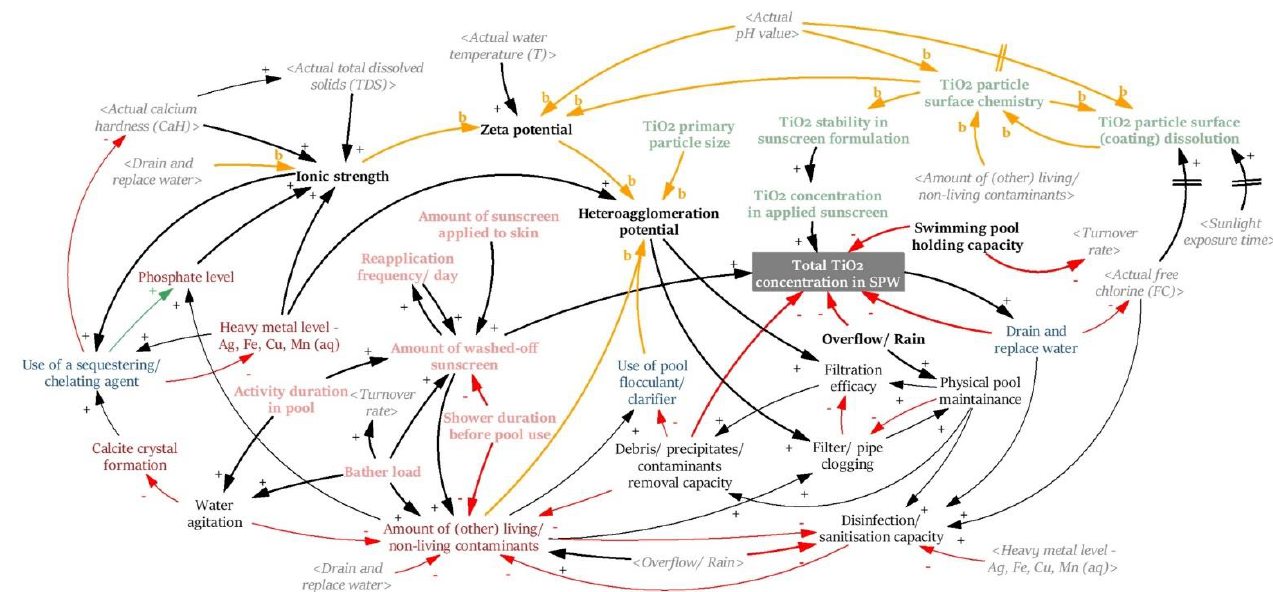
Figure 6. CLD 3: TiO 2 concentration in SPW. Colour code is the same as in the previous two figures. Additionally: pink variables represent the bathers’ behaviour, whereas green variables refer to sunscreen formulation and TiO 2 particle properties.